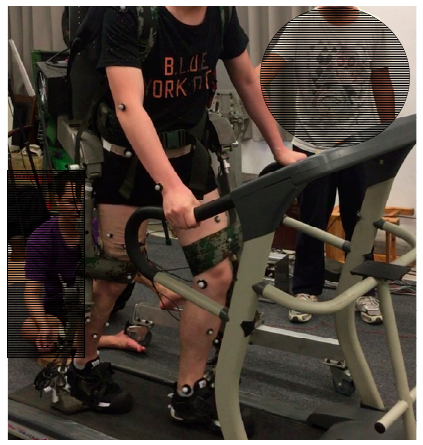
Figure 1. The argumentation exoskeleton prototype for load carriage experiments.